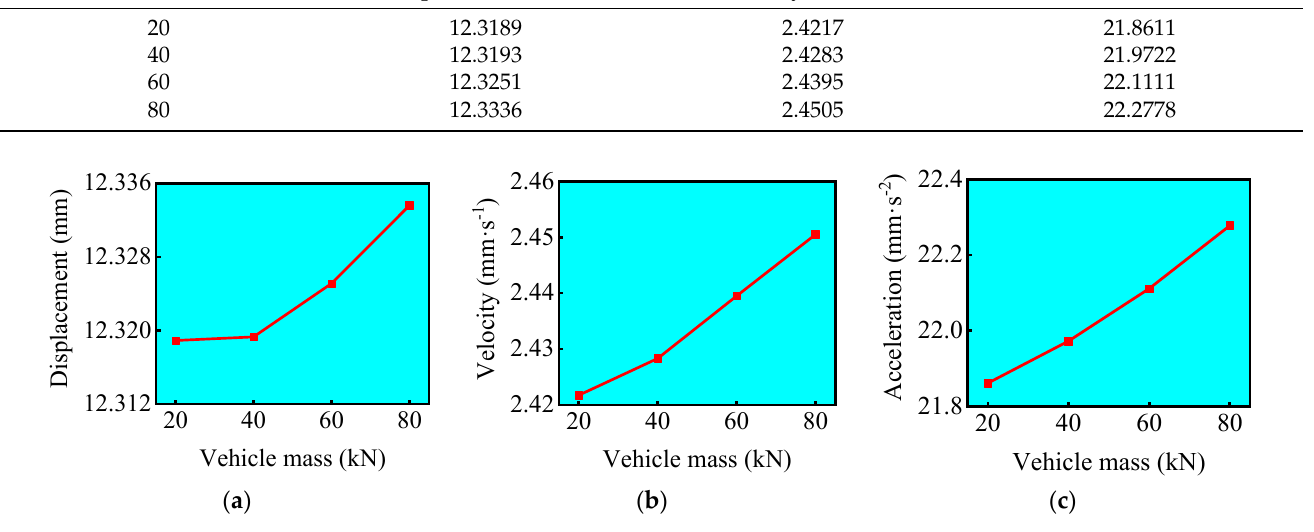
Figure 25. Peak value variation rule of different measuring points when the vehicle mass changes ( a ) displacement, ( b ) velocity, and ( c ) acceleration.